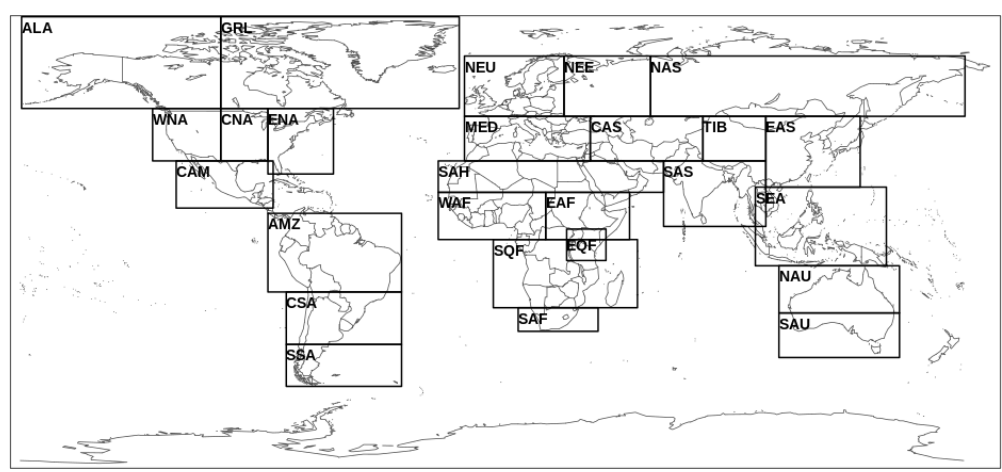
Figure 2. Evaluation regions as defined by Giorgi and Bi (2005) and employed in the PDF and time series analysis.